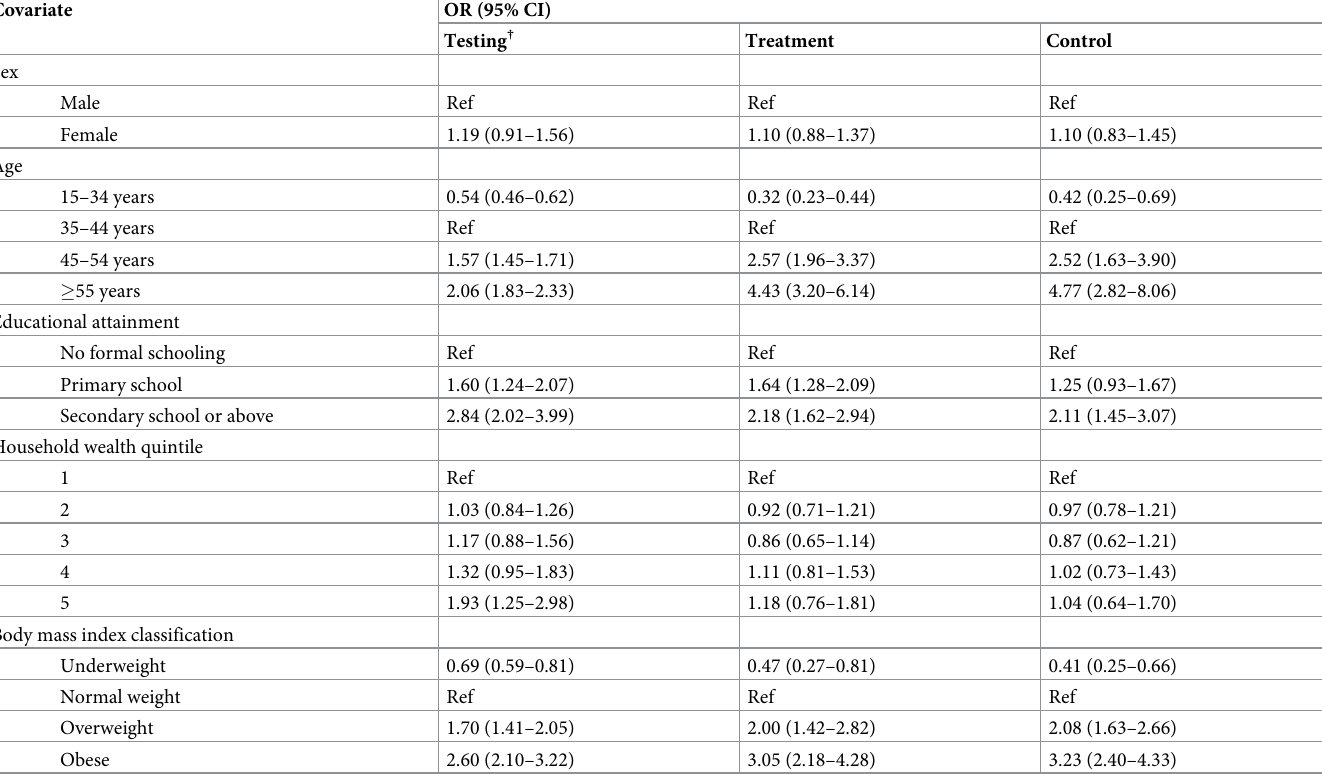
Table 3. Multivariable logistic regression analyses assessing the relationship between sociodemographic characteristics and testing, treatment, and control of diabe- tes in population-based surveys conducted in 22 low- and middle-income countries between 2008 and 2016. �